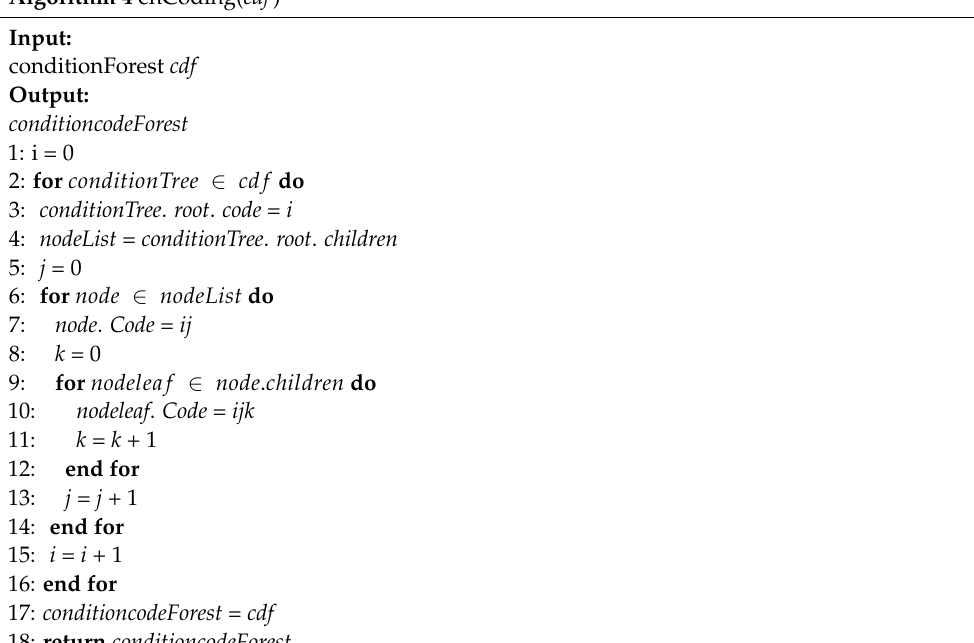
Algorithm 4 enCoding( cdf )